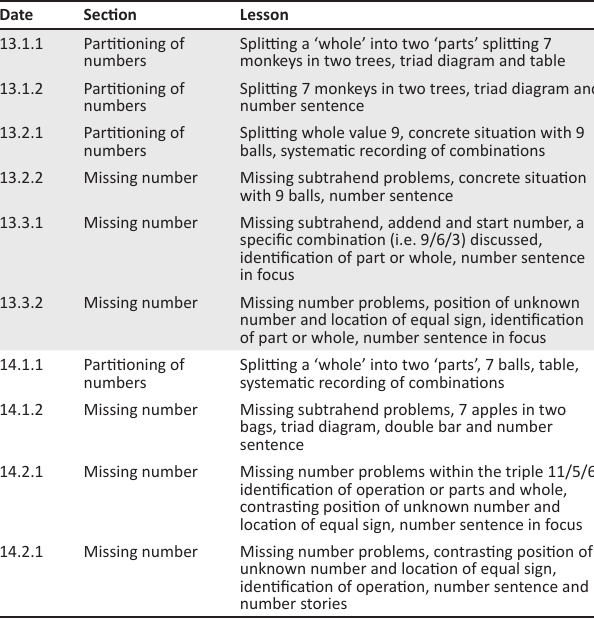
TABLE 1: Overview of teaching 2013 and 2014. TABLE 2: Simultaneity and connections within examples and simultaneity and